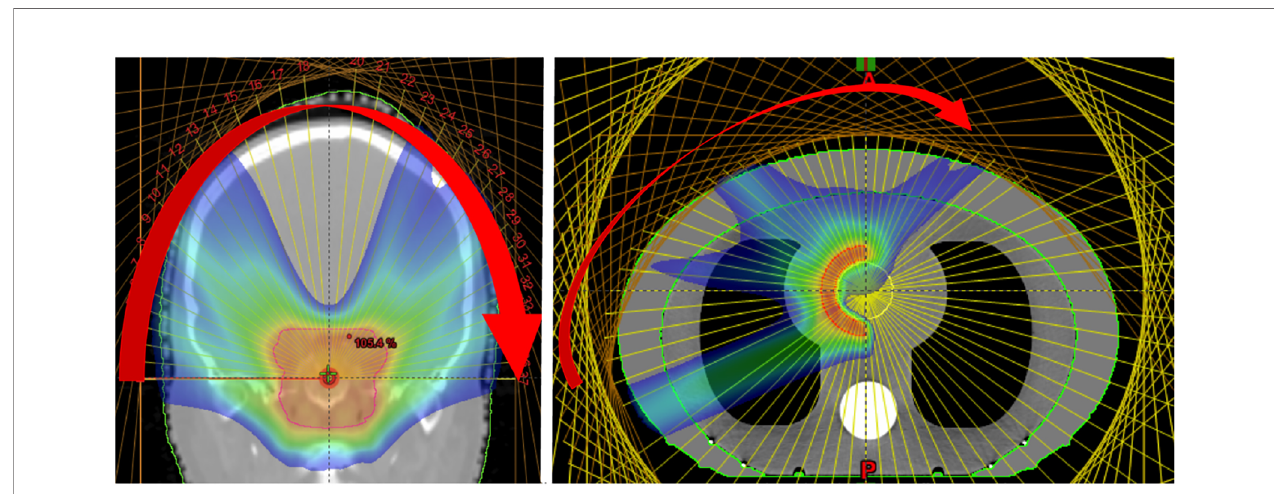
FIGURE 12 | Dose distributions obtained from the delivery of mono-energetic PAT. Coronal view of 37 fi elds for a brain tumor treatment, applied by a couch rotation every 5° (left). Axial view of a tissue equivalent lung phantom using 35 fi elds, also 5° rotation (right). Reproduced from (194) with permission from